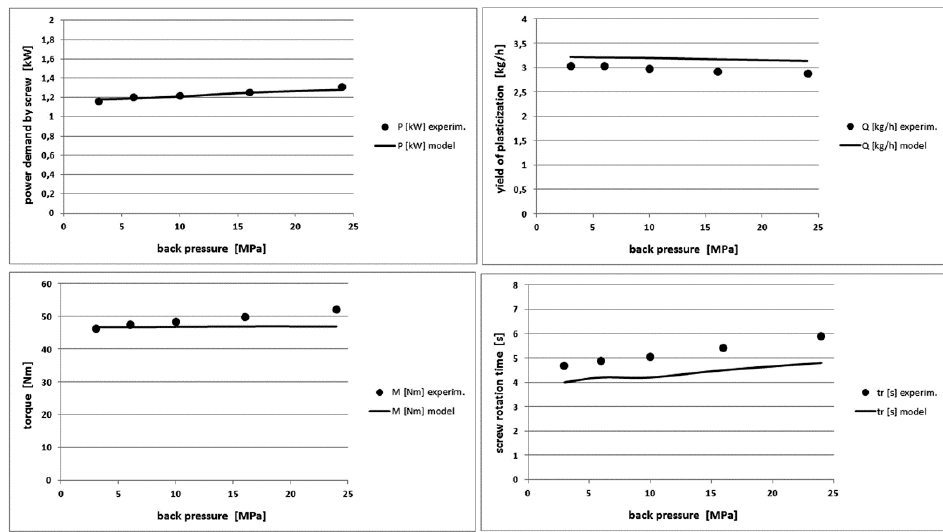
Figure 9. Comparison of other theoretical and experimental characteristics for different back pressure values in POM injection process.